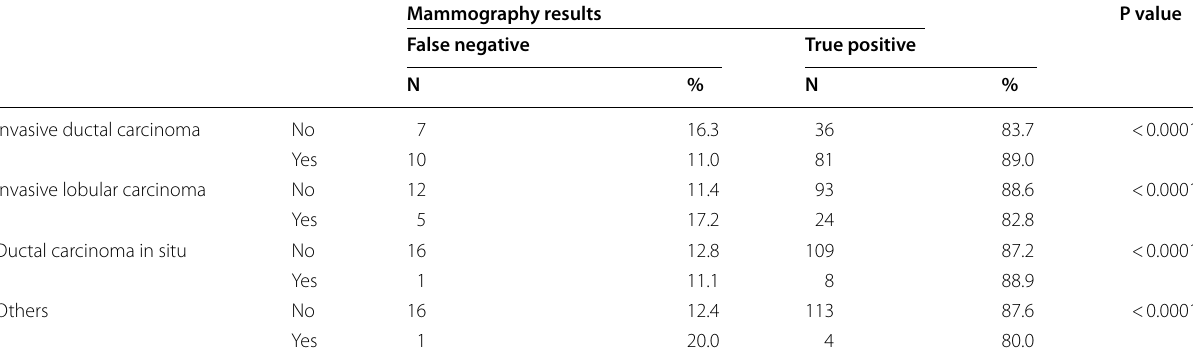
Table 1 Sensitivity of mammography in detecting different pathological types of breast malignancy